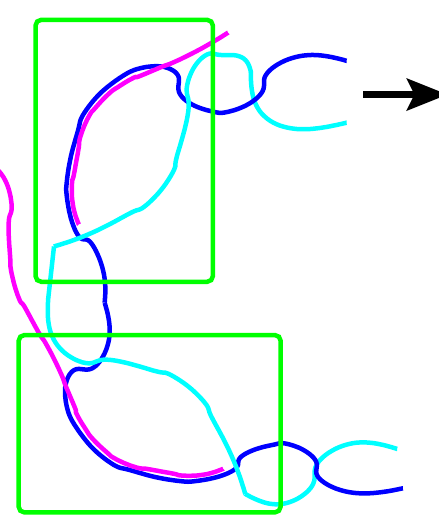
Fig. 5. Schematic diagram of a pair of polymerases simultaneously transcribing a gene. The green boxes represent the polymerases, the blue curve is the template strand, the cyan curve is the coding strand, and the magenta curve is the nascent RNA. The arrow indicates the direction in which the DNA is pulled through the polymerases. Approximately 35bp are protected from cleavage, i.e. this length of RNA is sufficiently inside the polymerase to be inaccessible to other macromolecular machines.